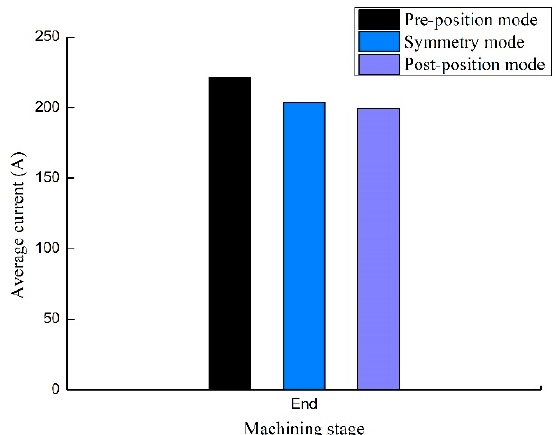
Figure 12. Average current for the three coupling modes with their highest feed rate at the end of machining.